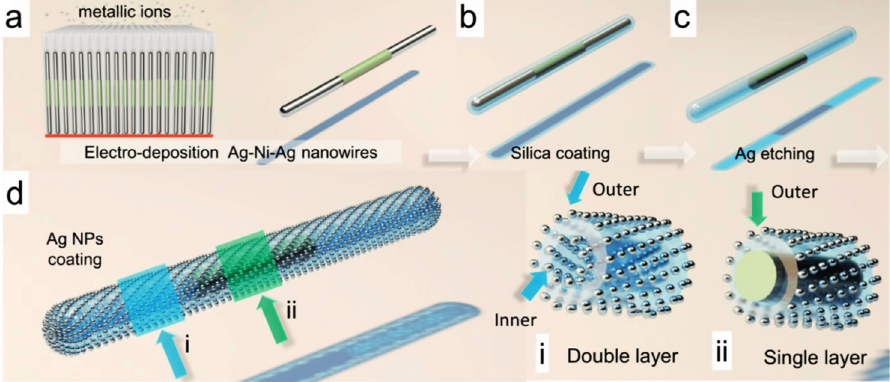
Figure 10. Schematics of the fabrication process of the partially hollow nanotubes. ( a ) Electrodeposition of Ag/Ni/Ag nanowires; ( b ) Silica shells coating; ( c ) Etching of Ag segment to get hollow nanotubes with solid Ni embedment; ( d ) Synthesis of Ag NPs on both the inner and outer surfaces of nanotubes. (Inserts are cross-section view of (i) the hollow segment and (ii) the Ni embedded segment of the nanotubes.) (With permission from